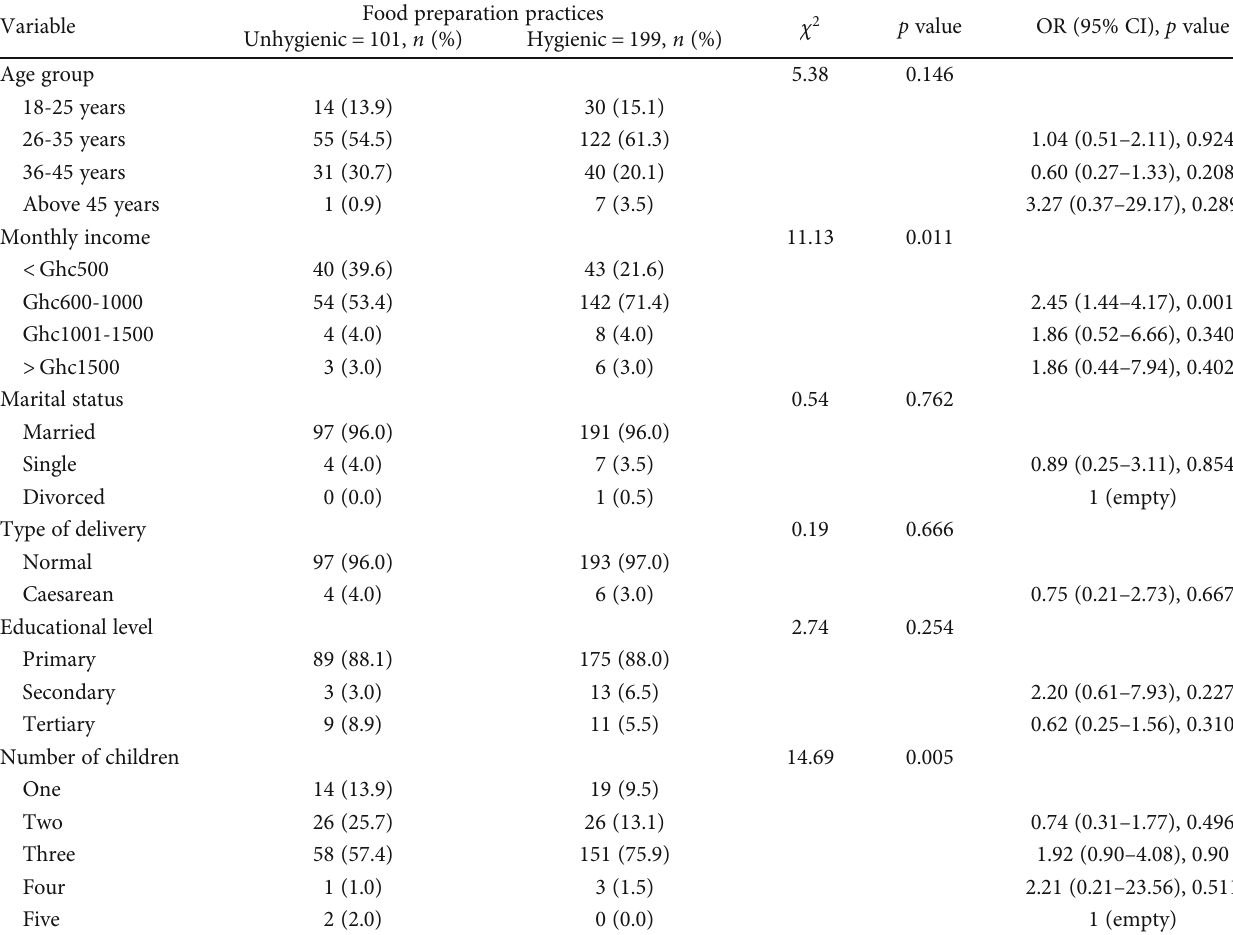
Table 6: Association between food preparation practices and respondent ’ s demographic